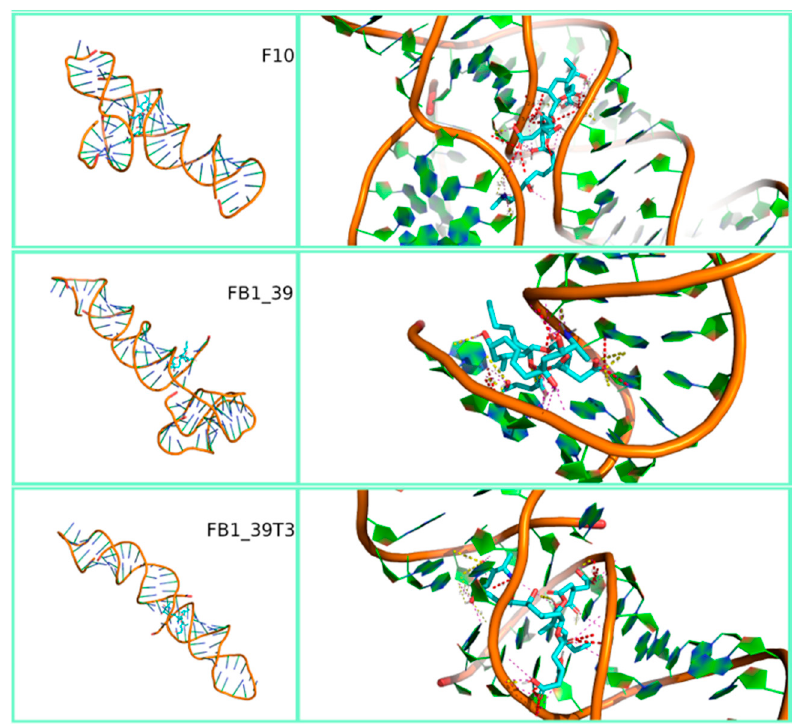
Figure 3. Three-dimensional representation of the best-docked pose of the three fumonisin B1 aptamers (F_10, FB1_39 and FB1_39t3). Full view on the left and zoom with contact maps on the right.